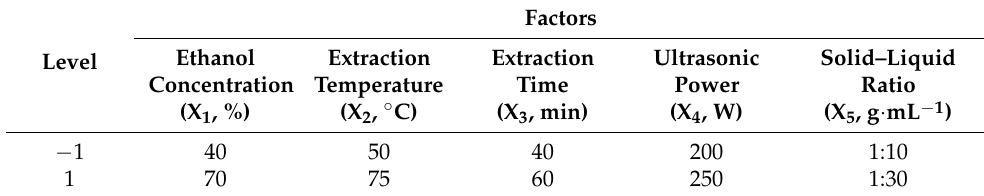
Table A2. Levels of factors selected for use in the PBD experiment.